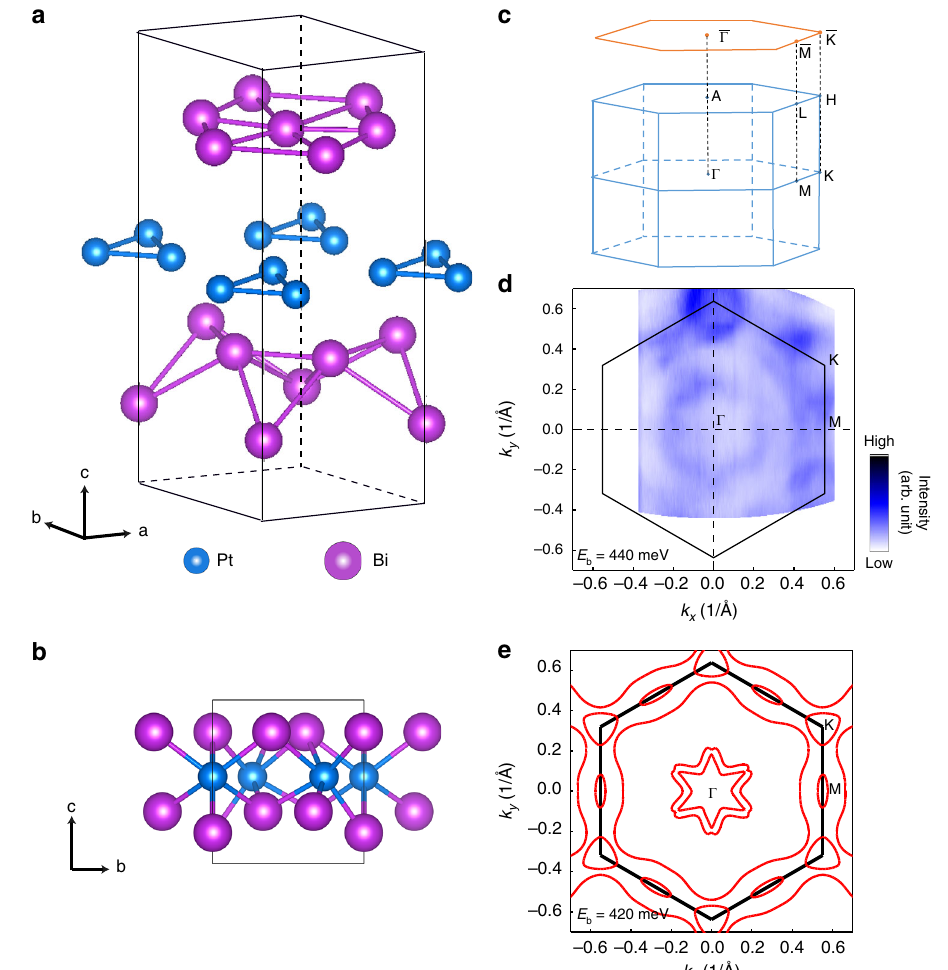
Fig. 1 The crystal structure and Fermi surface of PtBi 2 . a , b Crystal structure of trigonal layered PtBi 2 with space group P 31 m . c Bulk Brillouin zone (blue) and surface Brillouin zone (orange). d Constant-energy contour at E b = 440 meV and around k z = 0 measured by angle-resolved photoemission spectroscopy (ARPES) ( h ν = 8.8 eV). The color scale is linear as in all other images. e Calculated constant energy contour at E b = 420 meV and k z = 0